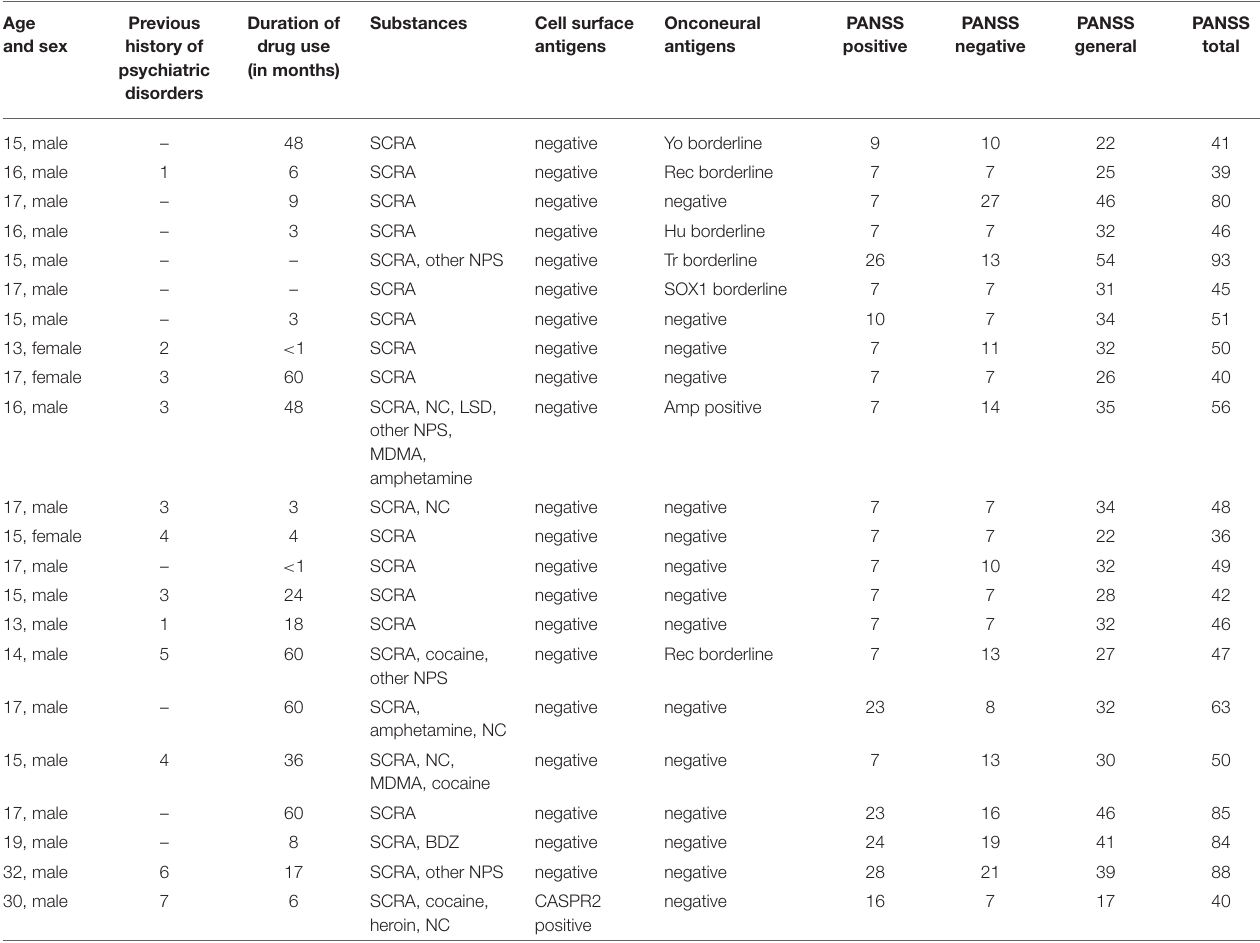
TABLE 2 | Clinical features and autoantibody results of each case. Age and